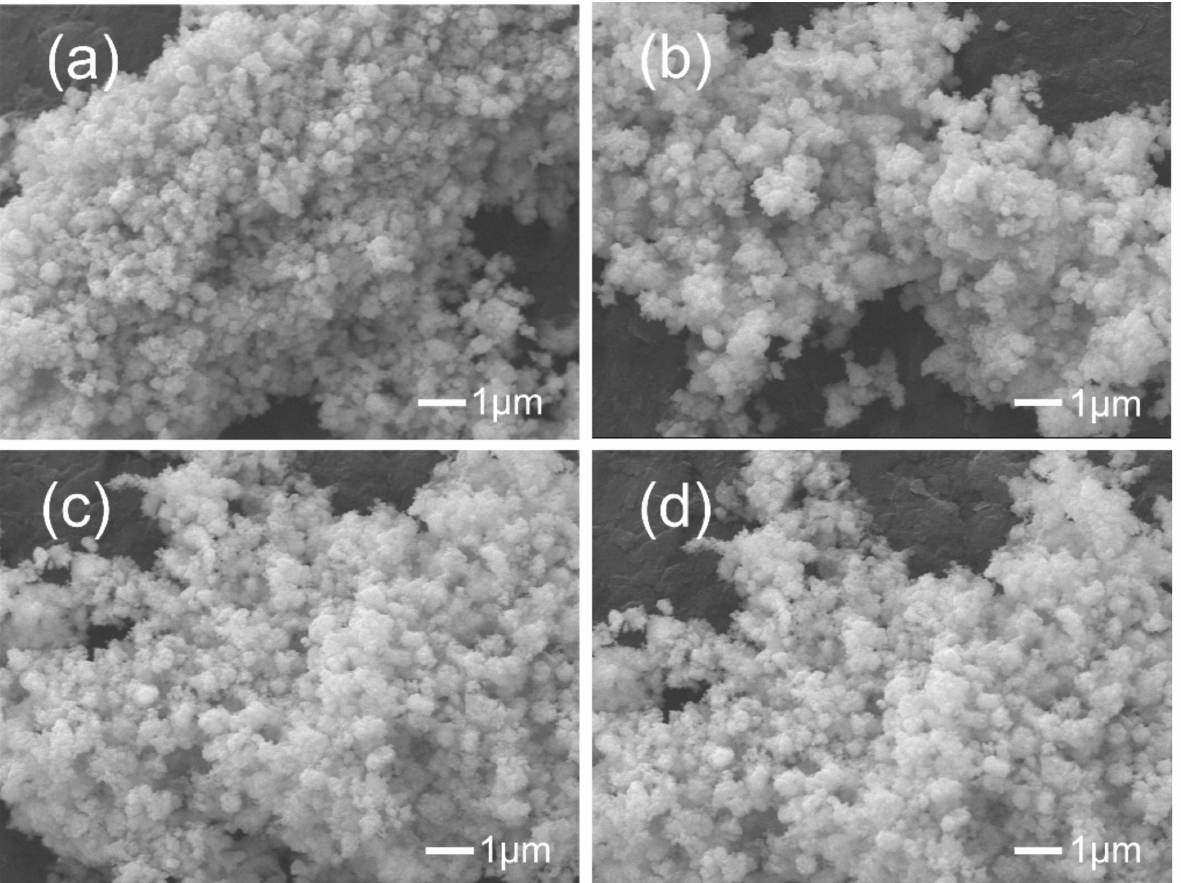
Figure 2. SEM images of ( a ) CeO 2 -NS before calcination; ( b ) Pt/CeO 2 -NS before calcination; ( c ) CeO 2 - NS and ( d ) Pt/CeO 2 -NS.